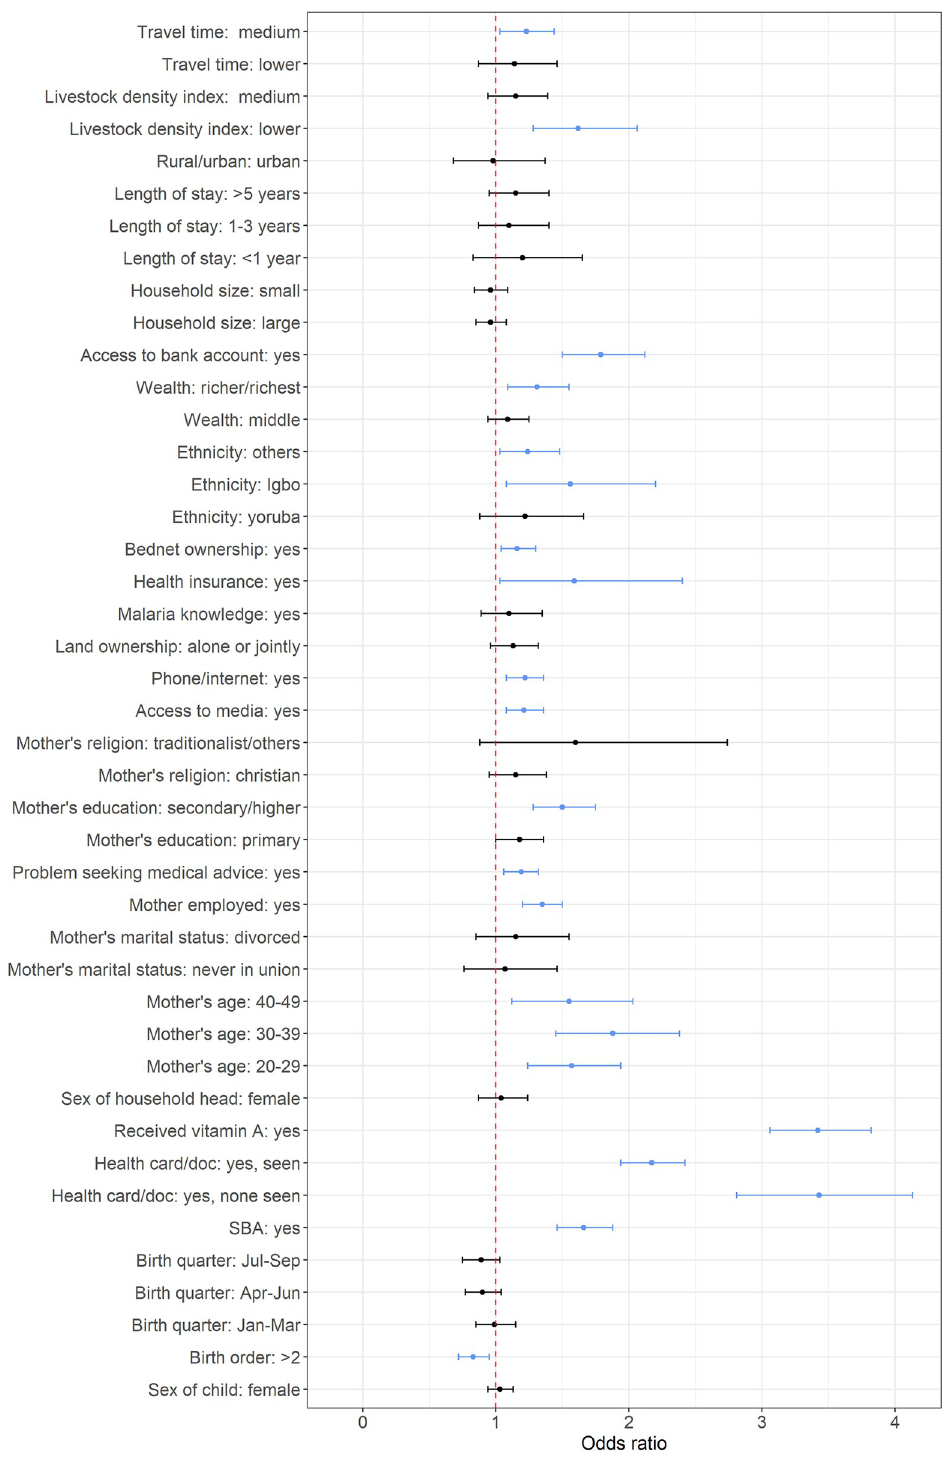
Fig 3. Plots of adjusted odds ratios and corresponding 95% credible interval based on Bayesian multilevel binomial analysis for MV vaccination coverage. The vertical dotted line marks the odds ratio of 1 and the blue lines mark significant